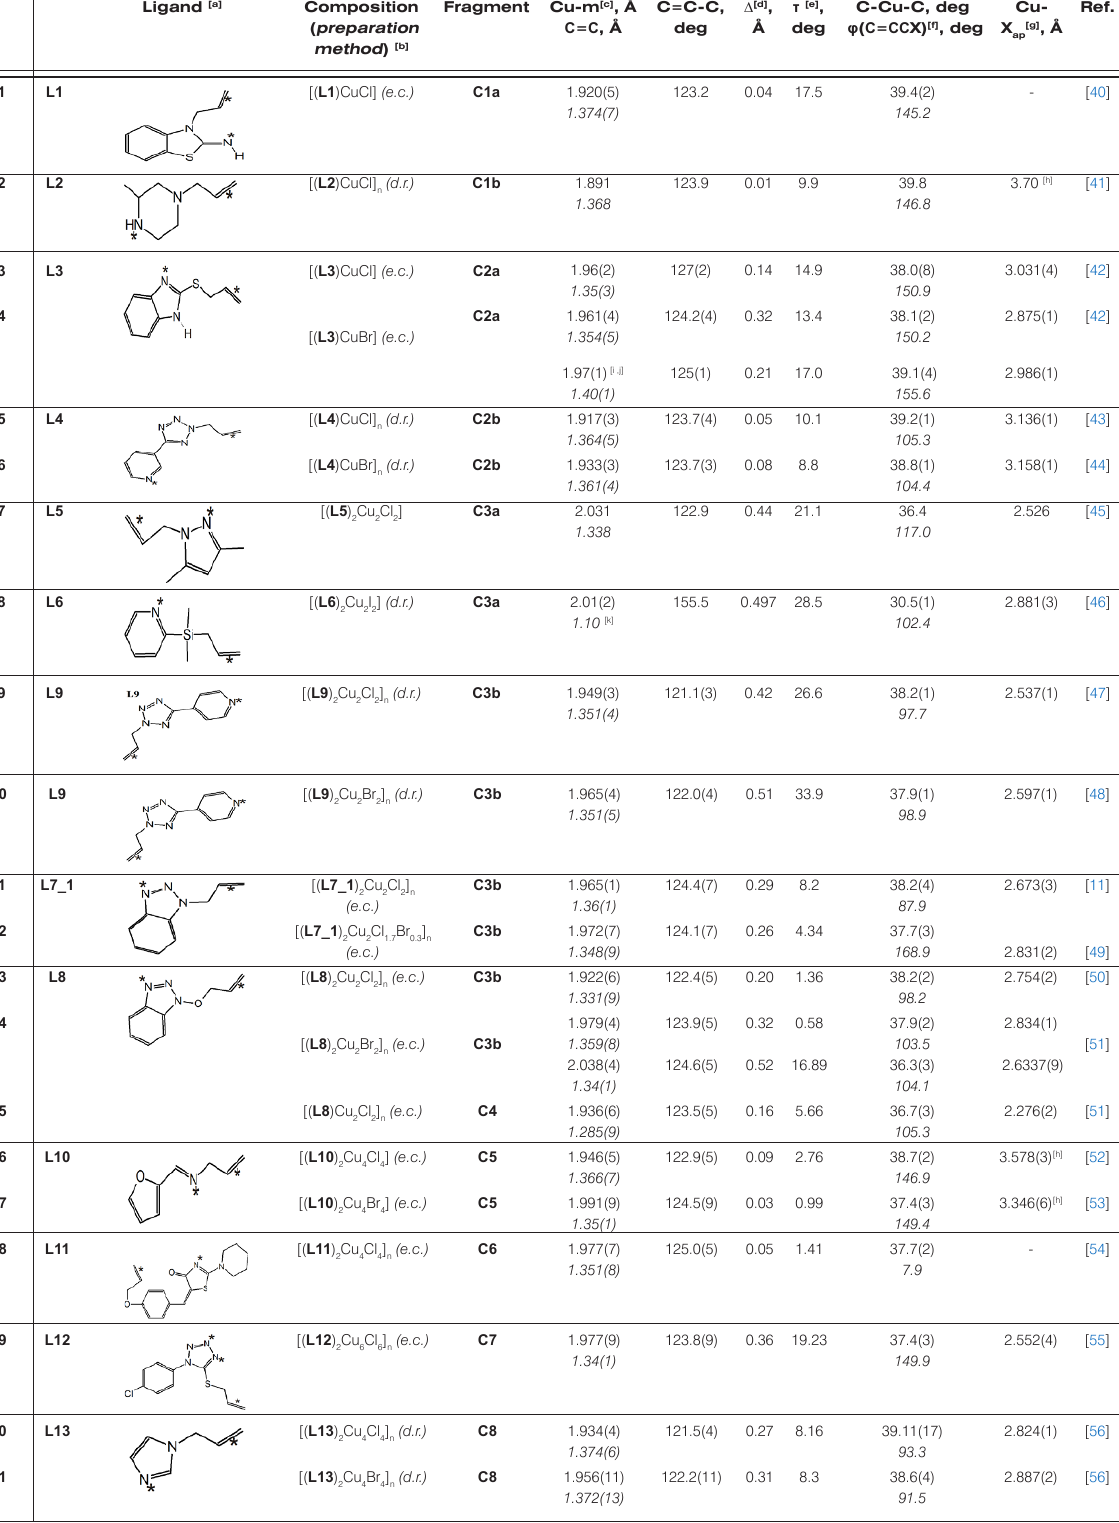
Table 1. Geometric parameters of Cu(I) π -core in the structures of copper(I) halide π